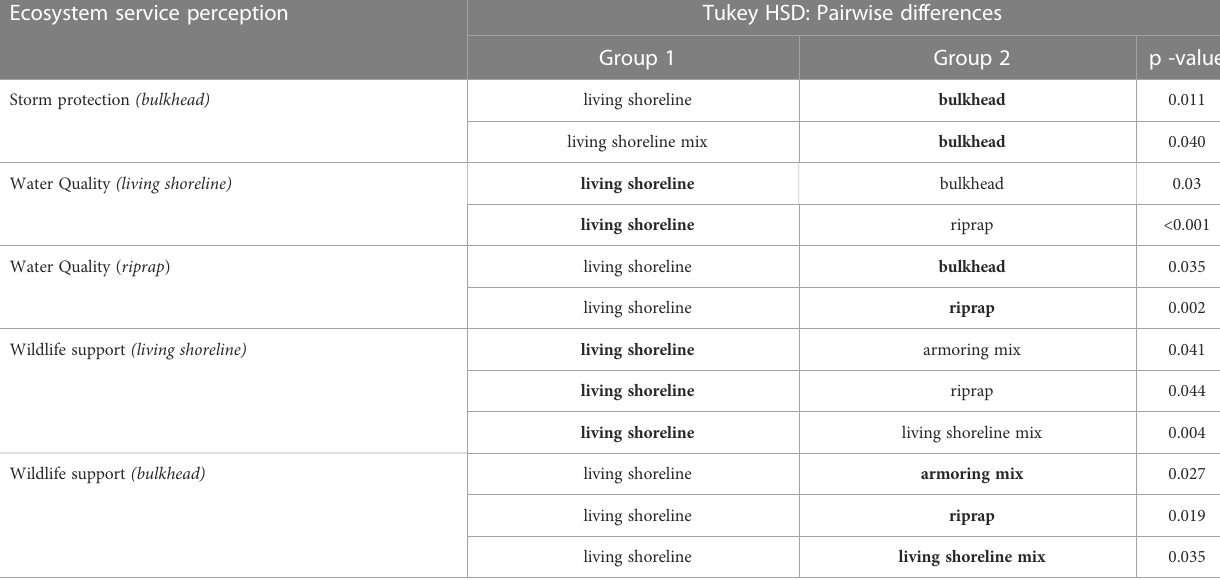
TABLE 5 Shoreline modi fi cation perception comparisons.